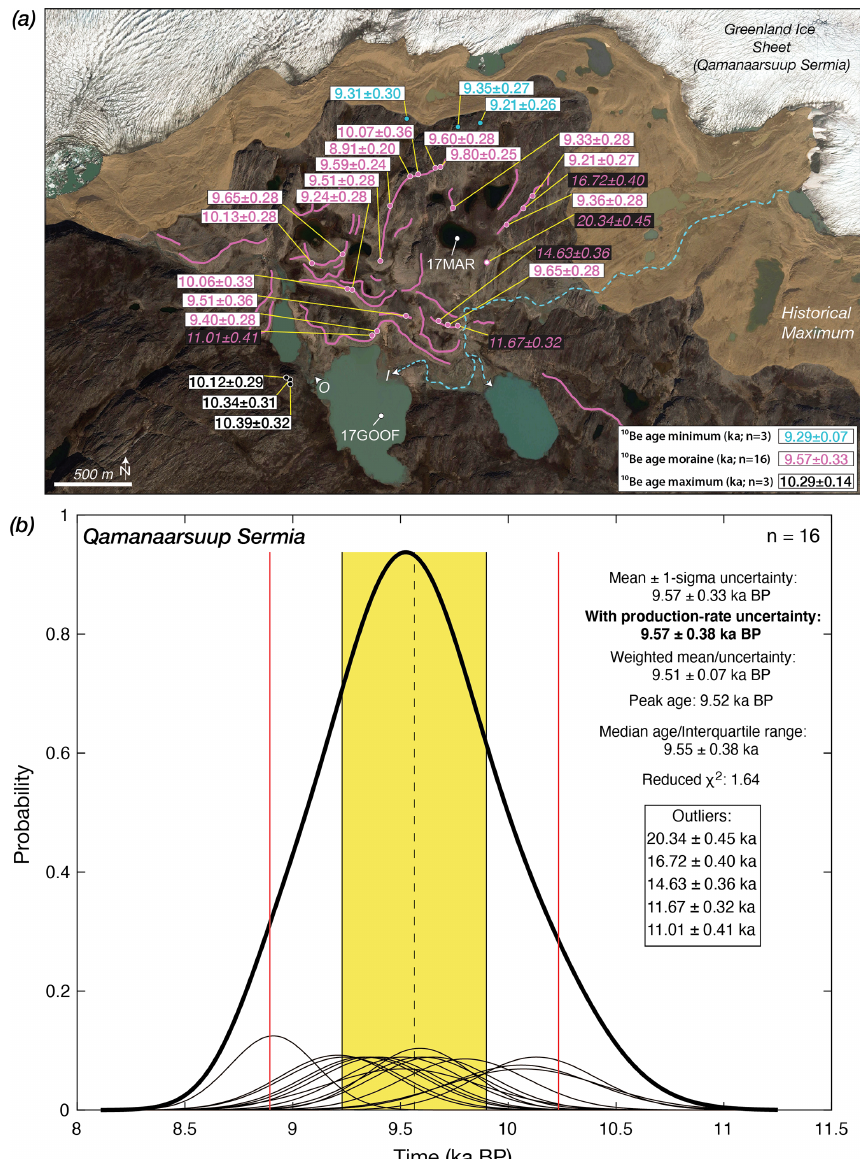
Figure 3. (a) Qamanaarsuup Sermia region depicting the Kapisigdlit stade moraines (pink) and retreat since from the historical maximum extent (brown shading); moraines were mapped in the field. 10 Be ages (ka ± 1SD) are from three morphostratigraphic groups: (1) erratic boulders perched on bedrock outboard of the Kapisigdlit stade moraines (black symbols and text), (2) Kapisigdlit stade moraine boulders (pink symbols and text), and (3) erratic boulders perched on bedrock inside the Kapisigdlit stade moraines (blue symbols and text). 10 Be ages influenced by isotopic inheritance are in italics with black boxes. Also shown are the sediment coring locations in Goose Feather Lake (17GOOF) and Marshall Lake (17MAR). The dashed blue line marks the route of meltwater from the GrIS to the Goose Feather Lake inflow (I). The outflow (O) for Goose Feather Lake routes meltwater back towards the GrIS. Map data: © Google Maps, Maxar Technologies. (b) Normal density estimates for the Kapisigdlit stade moraines from panel (a) . The age in bold includes the production-rate